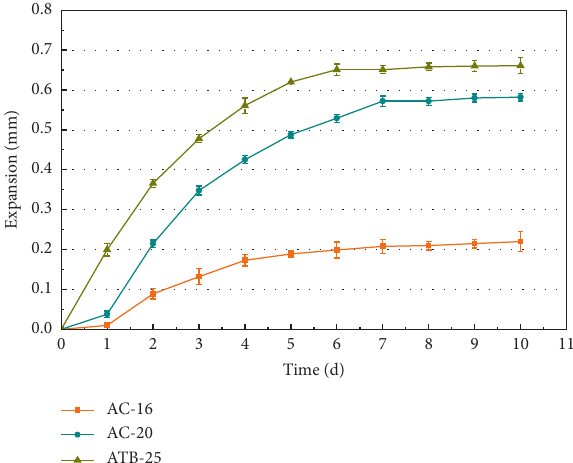
Figure 4: Expansion of steel slag mixture with different gradations.